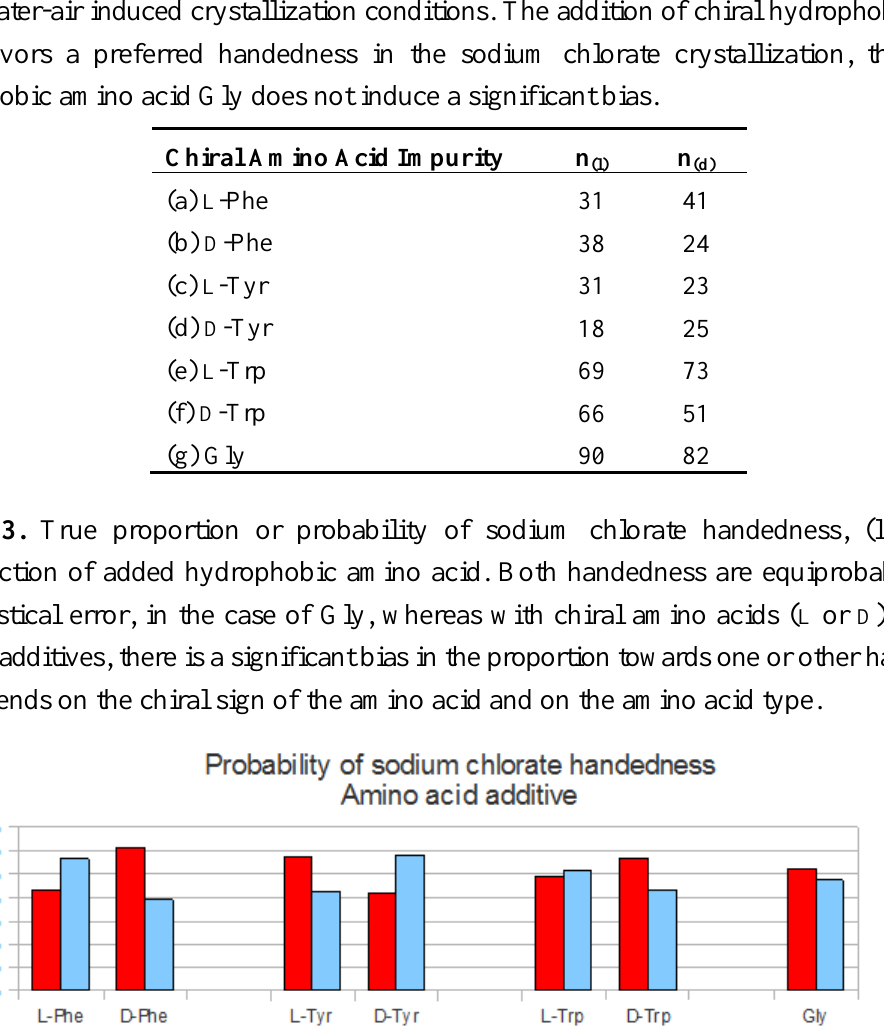
with amino acid impurities 3